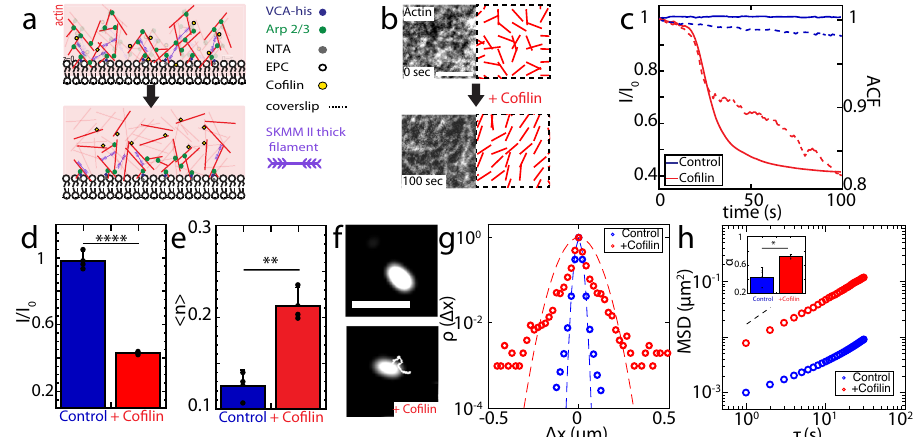
Fig.6|F-actindebranchingbyco fi linpartiallyrestoresmyosinmotility. Step1: polymerize actin. Step 2: add myosin. Step 3: add Co fi lin. a Schematic diagram for co fi lindebranchingprocess(before:top,after:bottom). b 74nMArp2/3-nucleated F-actinnetworkpre-(top)andpost-(bottom)additionofco fi lin.Rightpanelsshow the nematicorderalignment.Scale bar= 5 μ m. c Normalized network fl uorescence intensity ( I / I 0 ) (left axis) vs. time of the control case (blue solid line) vs. co fi lin addition(redsolidline),alongwithmyosinautocorrelation(rightaxis,dashedlines, control: blue, and co fi lin addition: red). d Steady state actin channel intensity bar plots. (**** p <0.0001. Error bars represent s.d. of the mean. N = 3 independent experiments for each condition. Two tailed t test). e Averaged nematic order parameter < n > for 74nM Arp 2/3-nucleated F-actin network + (red), and -co fi lin